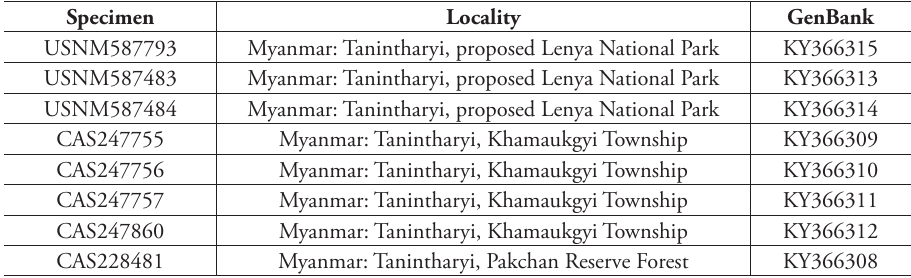
Table 1. Voucher information for specimens sequenced for this study. See holding institution for ad- ditional locality